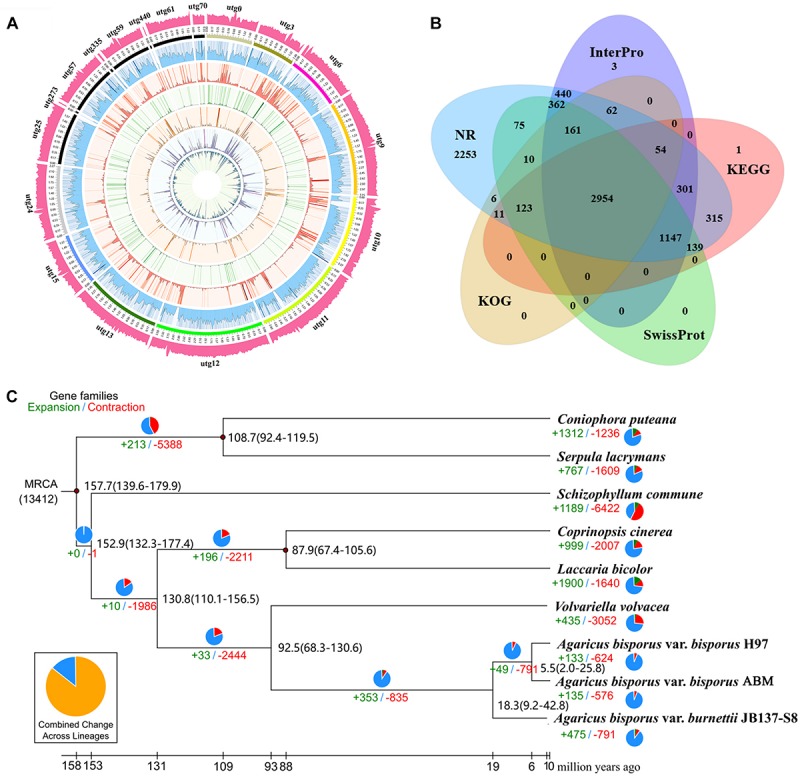
The ABM genome and evolution of A. bisporus. (A) The A. bisporus genome. Outside to inside of concentric circles show GC content, assembly scaffold number, gene density, non-coding RNA (ncRNA), all repeat content, LTR content, LINE content, DNA repeat content, satellite content. (B) Venn diagram of the predicted gene number in InterPro, KEGG, SwissProt, KOG, and NR database. (C) Numbers on the nodes represent the divergence times. The number of expanded (green) and contracted (red) gene families in each lineage is shown on the corresponding branch. MRCA, most recent common ancestor.